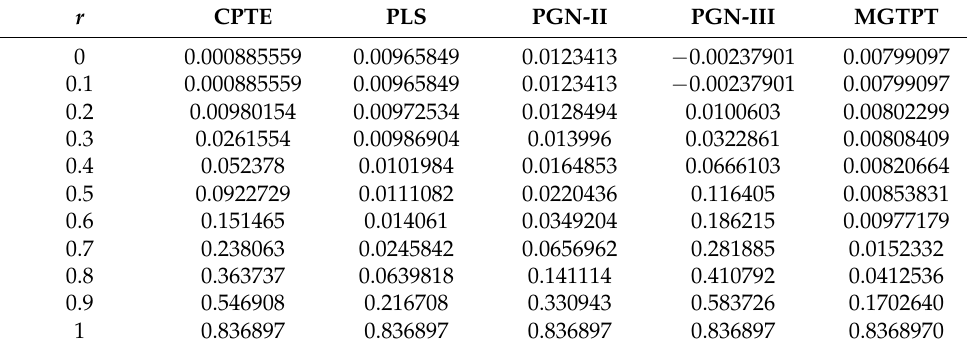
Table 1. The temperature variation θ under photothermal models.